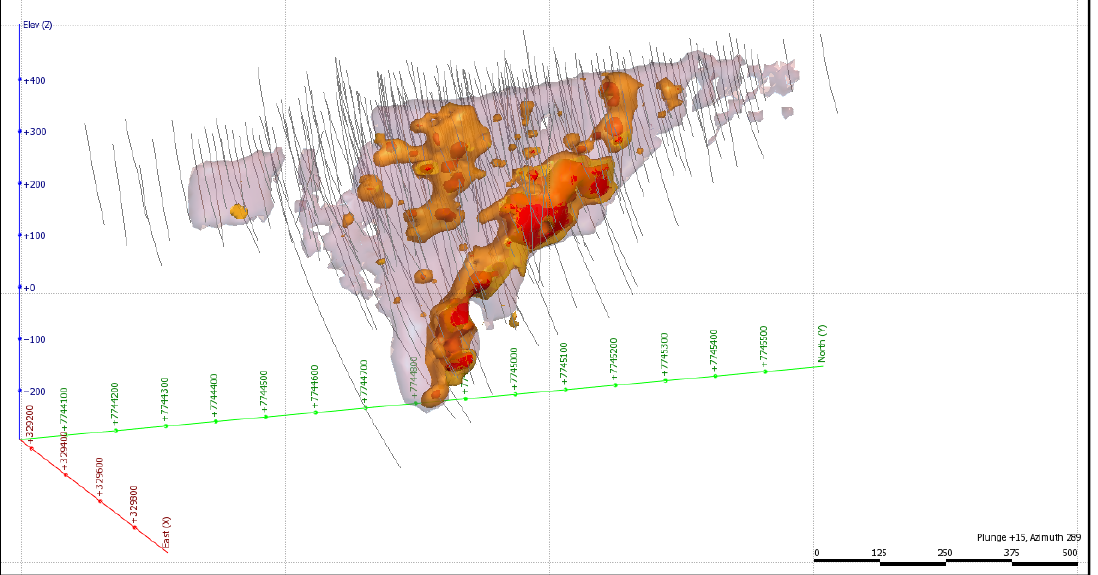
Figure 2 . Morphology of the Valhalla orebody. Pink–albitite; Yellow–low grade ore; Red–high grade